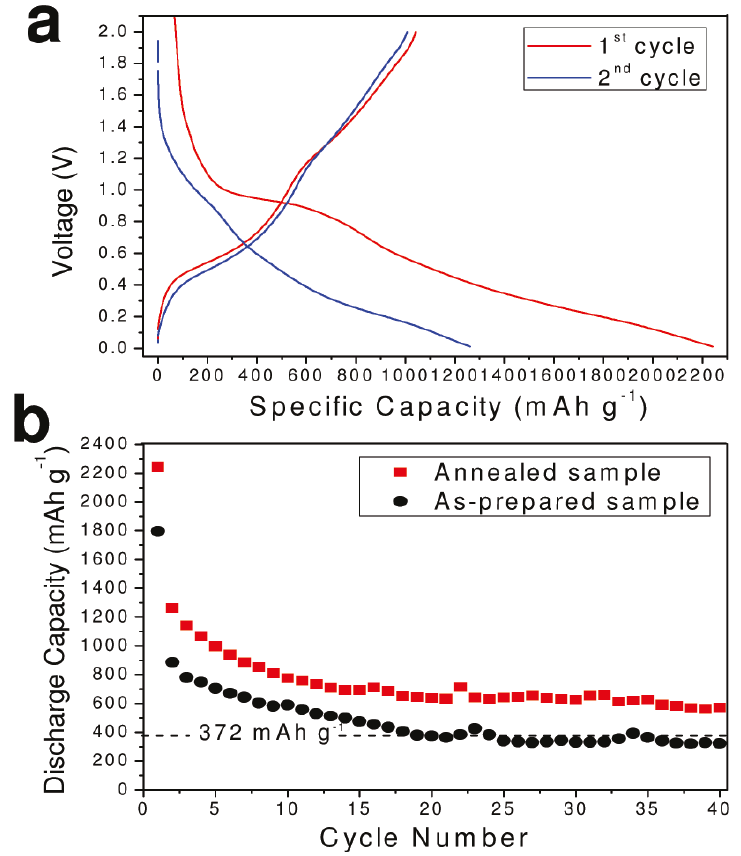
Figure 7. ( a ) Discharge/charge voltage profiles of annealed SnO between 0.01 and 2.0 V at a 0.2 C rate; ( b ) cycling performance of as-synthesized and annealed SnO nanoboxes at 0.2 C. Adapted with permission from [58]. Copyright 2012 2 American Chemical